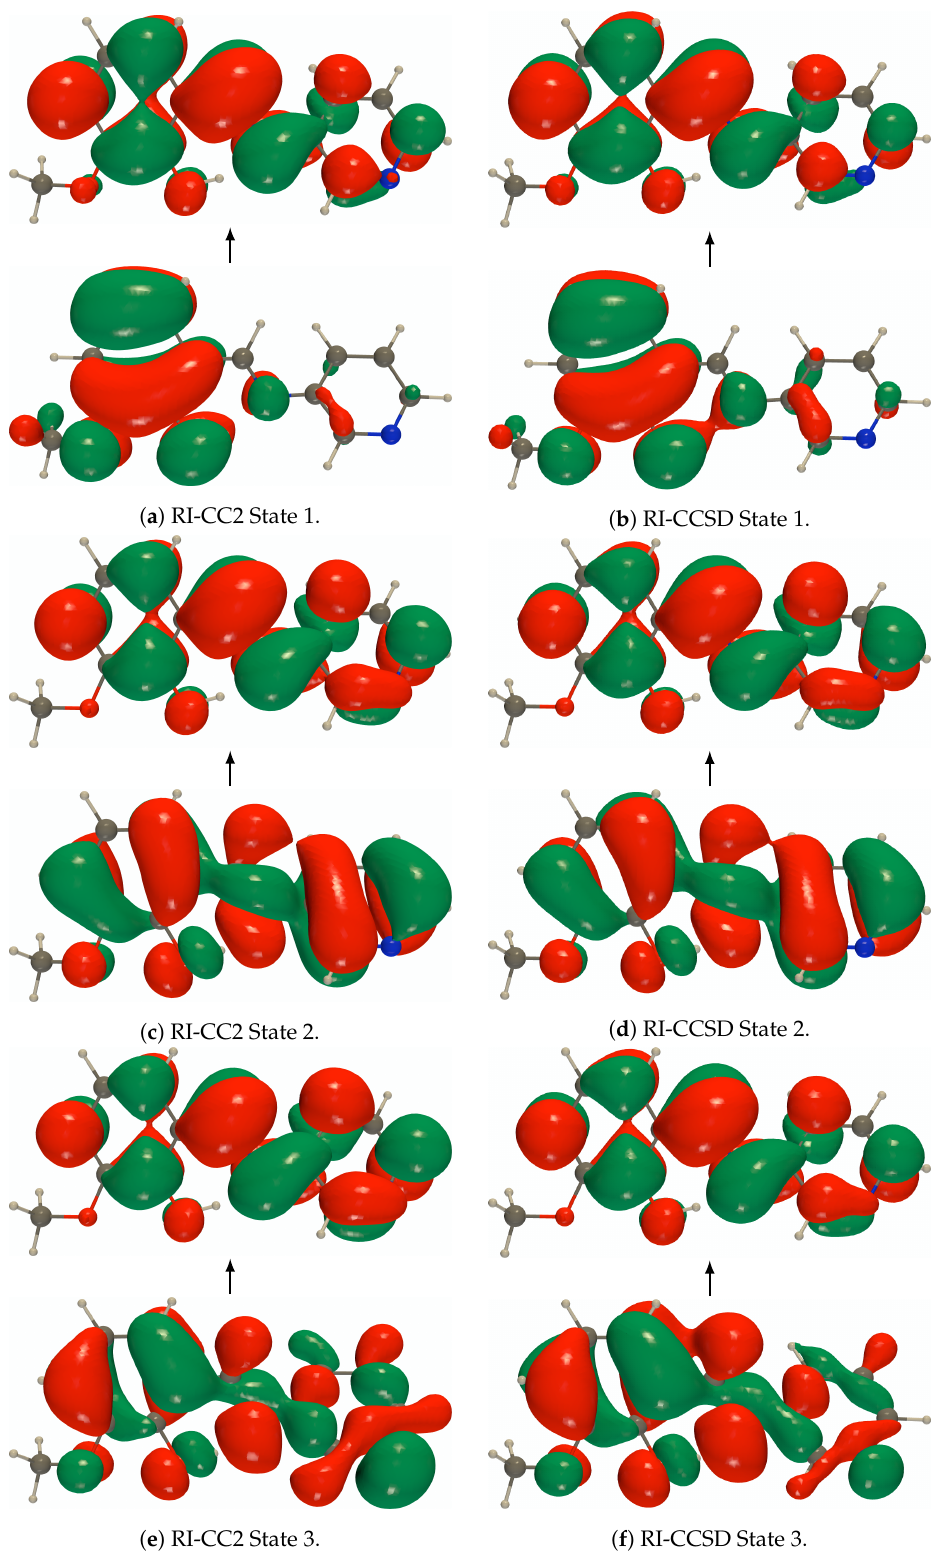
Figure A1. def2-TZVPD NTOs (holes below the arrows and particles above them, the red (green) lobes are the positive (negative) ones) of the isolated PYV3 [PYV3] enol form (isovalue of